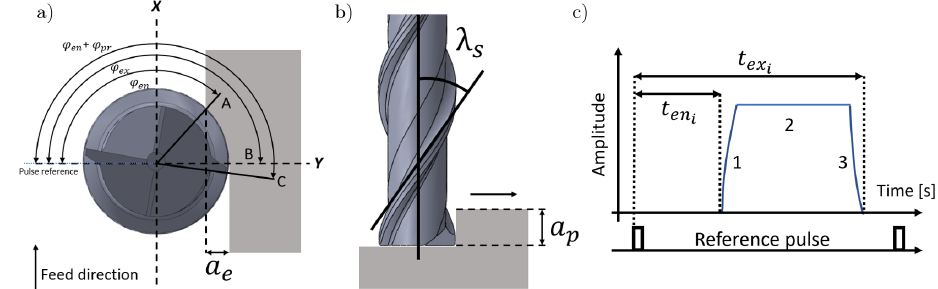
Figure 1. Main parameters of the end-milling process. ( a ) Top view, ( b ) front view, and ( c ) time history of the cutting